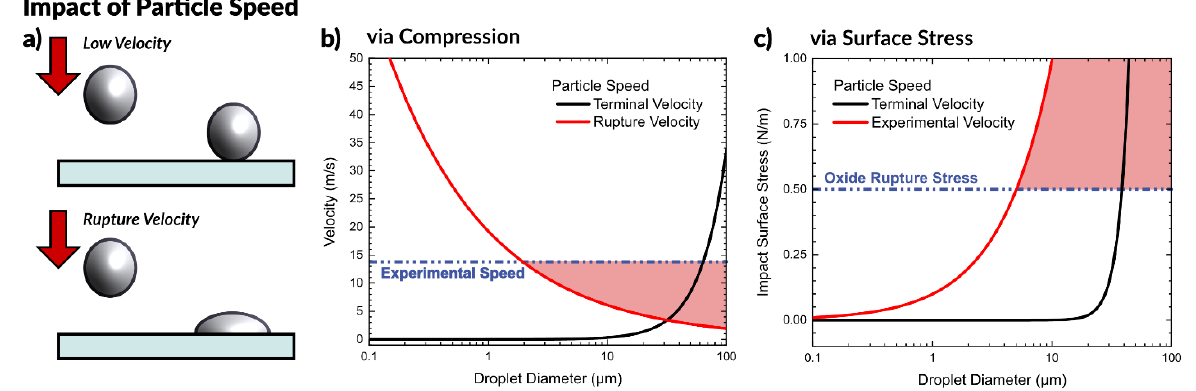
Figure 4. Impact of particle speed at impact. ( a ) Depiction of a droplet hitting a surface at low velocity and coming to rest, compared to a droplet hitting a surface at a velocity sufficient to rupture the oxide, deform the drop, and pin it to the surface. ( b ) Graph to predict the required rupture velocity as a function of particle size, compared with the terminal velocity of a particle and the experimental velocity of aerosolized liquid metal particles. ( c ) Graph of predicted surface stress for a particle at impact as a function of particle size at experimental velocity and terminal velocity. In both plots, regions highlighted in red are conditions that create particles with sufficient kinetic energy to rupture on impact.